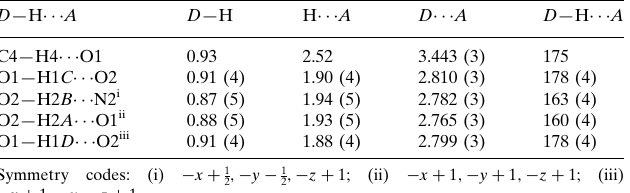
Hydrogen-bond geometry (A˚ , (cid:2)